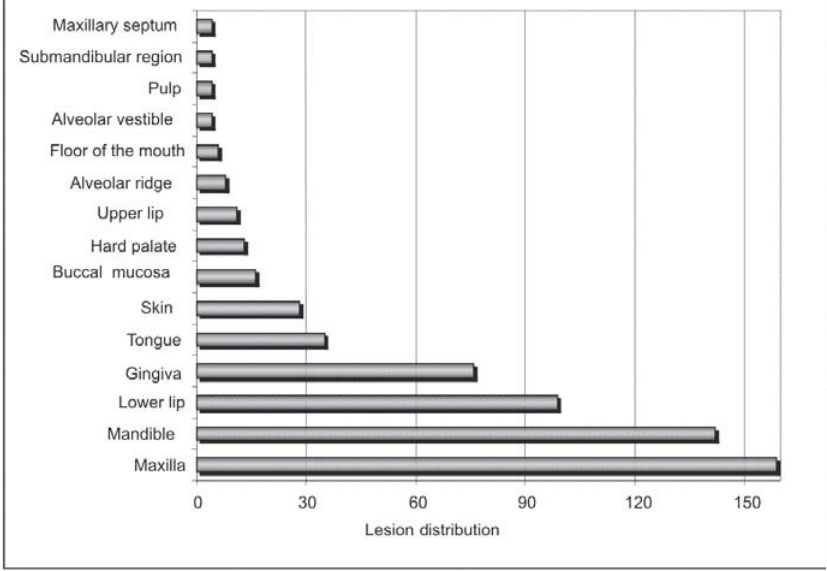
FIGURE 2- Lesion distribution by location